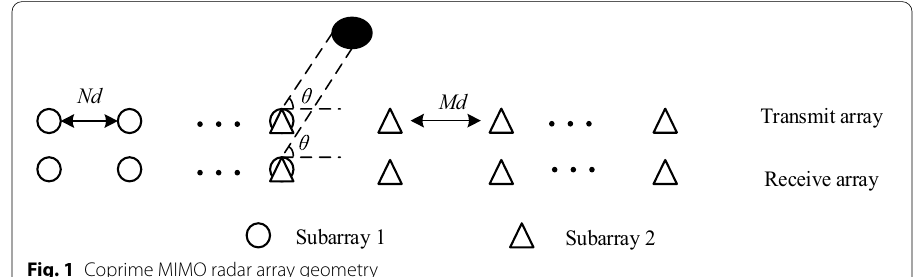
Fig. 1 Coprime MIMO radar array